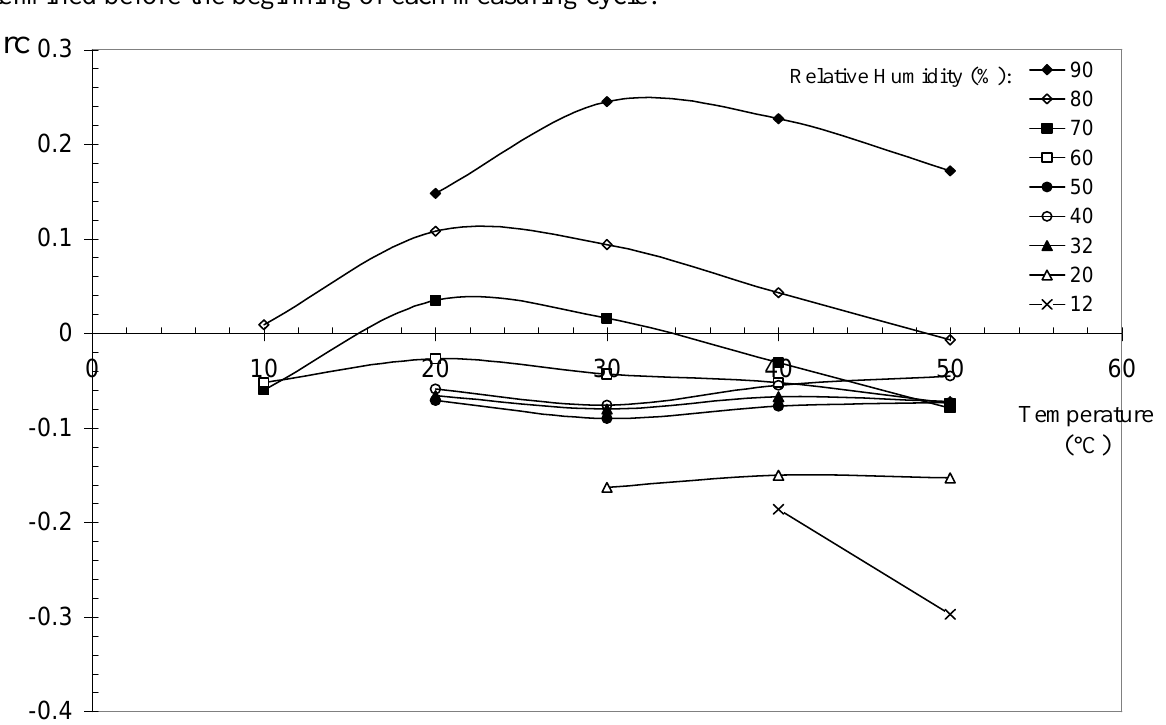
Figure 9. Normalized relative resistance vs. temperature in iso-humidity